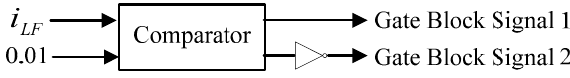
Figure 7. Gate block control scheme of LFAC.